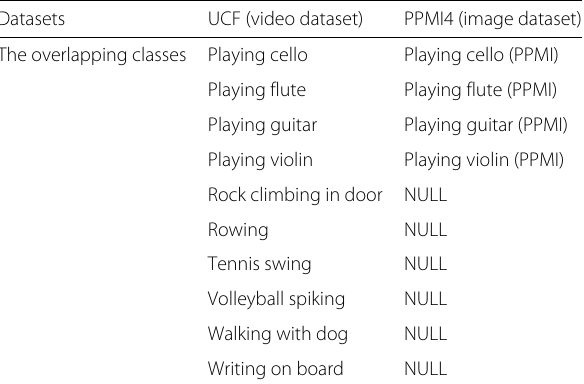
Table 3 The classes of UCF ←